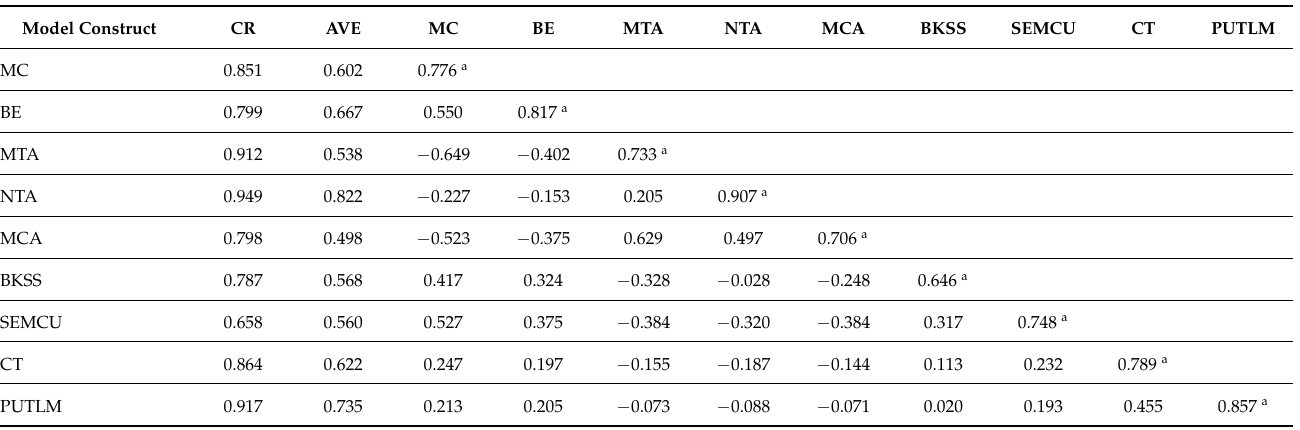
Table 5. Composite reliability (CR), average variance extracted (AVE), square root of AVE (on the diagonal), and correlations among latent variables.